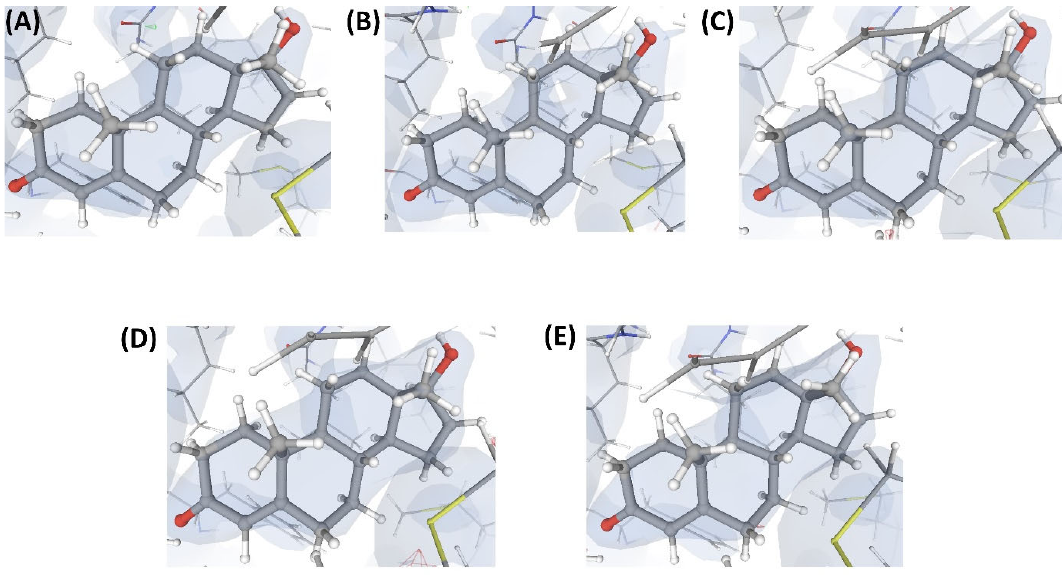
Figure 5. Electron density maps around the ligand L’ bound at site S2 of the structures discussed in case study ‐ 1. ( A ) C1. ( B ) C2. ( C ) C3. ( D ) C4. ( E ) C17. For details on the resolution of the structures, graphical representation styles, and color codes of density maps, kindly refer to the legend of Figure 4.